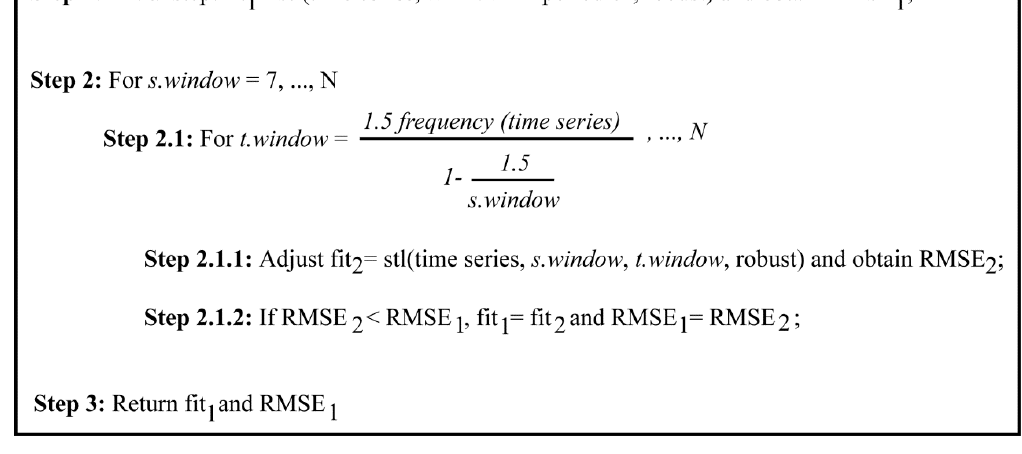
Figure 2. Schematic view of stl.fit().